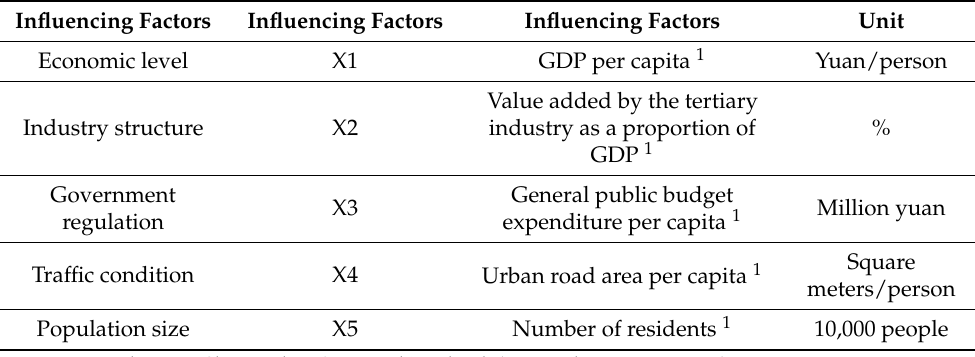
Table 5. The influencing factor of the level of coupling